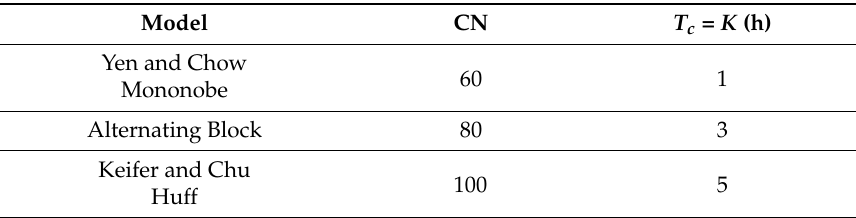
Table 4. Combinations of five rainfall temporal distribution models, three CN values and three T c (= K ) values considered in this study.